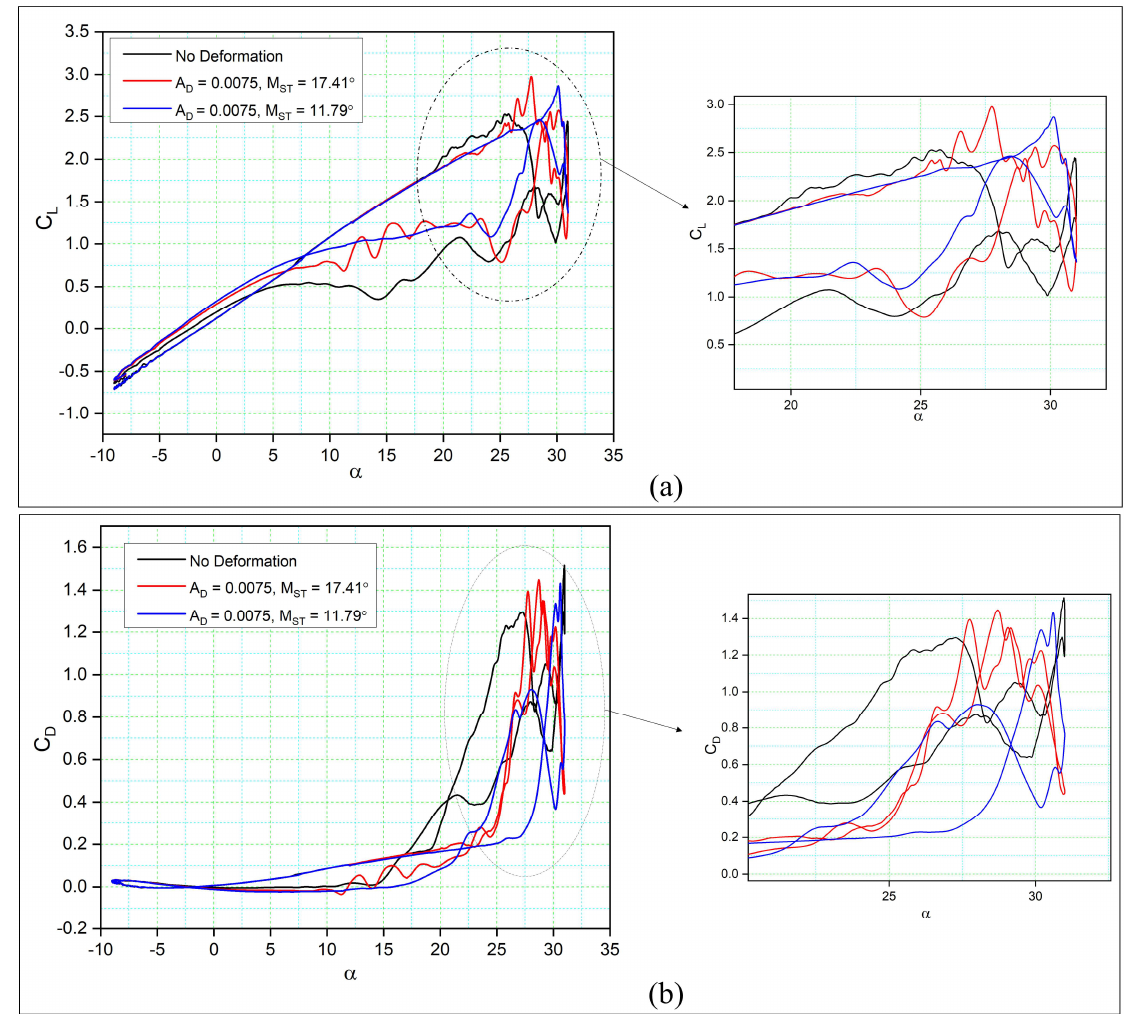
Figure 11. Hysteresis cycles for ( a ) the lift coefficients of DMLE airfoils and ( b ) the drag coefficients of DMLE airfoils in comparison to those of the reference (unmorphed) airfoil. Figure 12a compares the aerodynamic coefficients for three different amplitudes ( 𝐴 (cid:3005) ) to those of a reference airfoil. It is clear that the different amplitudes result in higher 𝐶 (cid:3013) values for all the DMLE airfoils during the upstroke. At lower values of 𝐴 (cid:3005) ( 𝐴 (cid:3005) = 0.01) and 𝑀 (cid:3020)(cid:3021) = 14.75°, the 𝐶 (cid:3013),(cid:3040)(cid:3028)(cid:3051) reaches 3.04, while the reference airfoil’s 𝐶 (cid:3013),(cid:3040)(cid:3028)(cid:3051) is 2.53, showing a 20.15 % increase in 𝐶 (cid:3013),(cid:3040)(cid:3028)(cid:3051) . However, the flow reattachment for this case of the DMLE airfoil is delayed compared to that of the reference airfoil during the downstroke. During the pitching oscillation of the reference airfoil, the flow separation and stall occur at an angle of attack of 25°. However, with the droop deformation of the leading edge, the stall occurs at an angle of attack of 30°, thereby delaying the stall by 5°. In the case when 𝐴 (cid:3005) = 0.005, slightly higher lift coefficients are found, as 𝐶 (cid:3013),(cid:3040)(cid:3028)(cid:3051) in- creased from 2.53 to 2.8, with a 10.67 % increase in comparison to the reference airfoil (Figure 12a). As the value of 𝐴 (cid:3005) varies with the morphing time ( 𝑀 (cid:3020)(cid:3021) ), the main part of the droop deformation is closer to the leading-edge point. In case of 𝐴 (cid:3005) = 0.05, the stall angle is delayed 12% in comparison to the reference airfoil. In addition, the flow reattach- ment occurs earlier in this DMLE case. With 𝐴 (cid:3005) = 0.0075, the lift coefficient of the DMLE airfoil increased by 11.46% as com- pared to the reference airfoil, and the flow was also reattached earlier for the DMLE airfoil